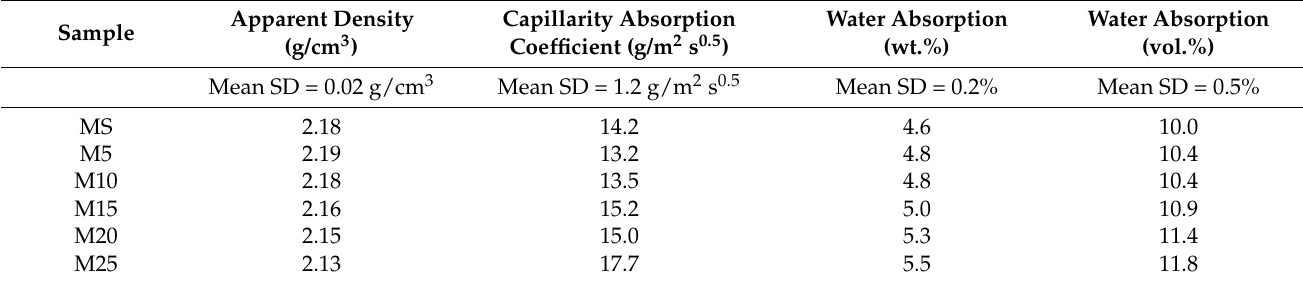
M25 mortar mixtures at 28 days of curing.